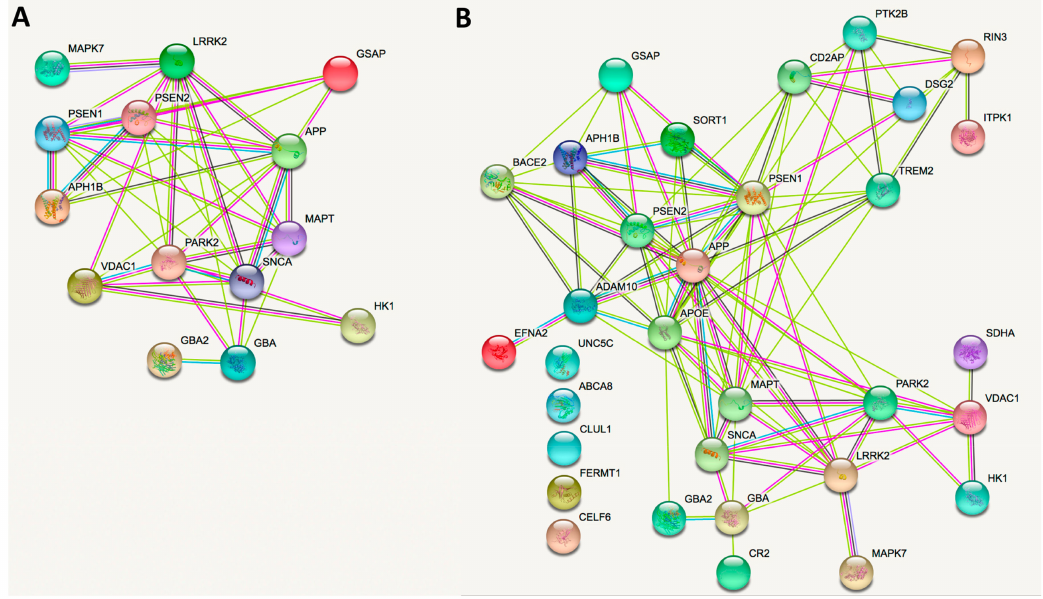
Figure 3. STRING-based network analysis of protein products of genes involved in familial AD or